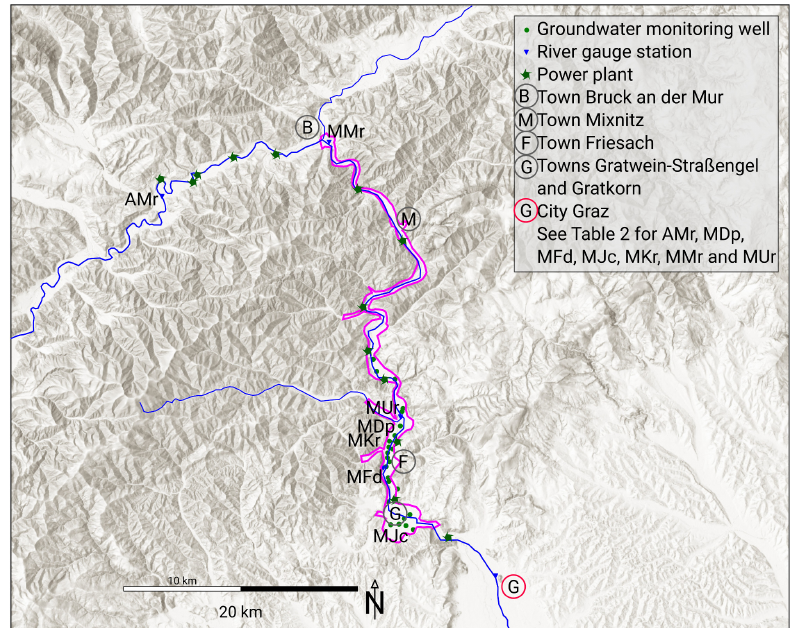
Figure B2. Detailed map for the Murdurchbruchstal subregion